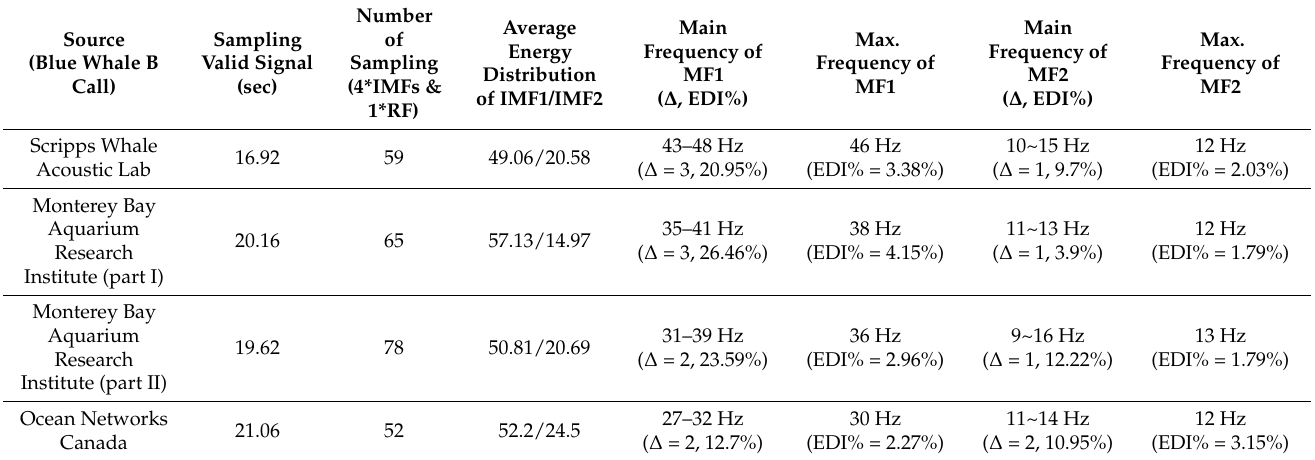
Table 10. MF1 and MF2 of the IMFs, average EDI, main frequency band, max frequency with thresholds for the SWAL’s, MBARI’s and ONC’s